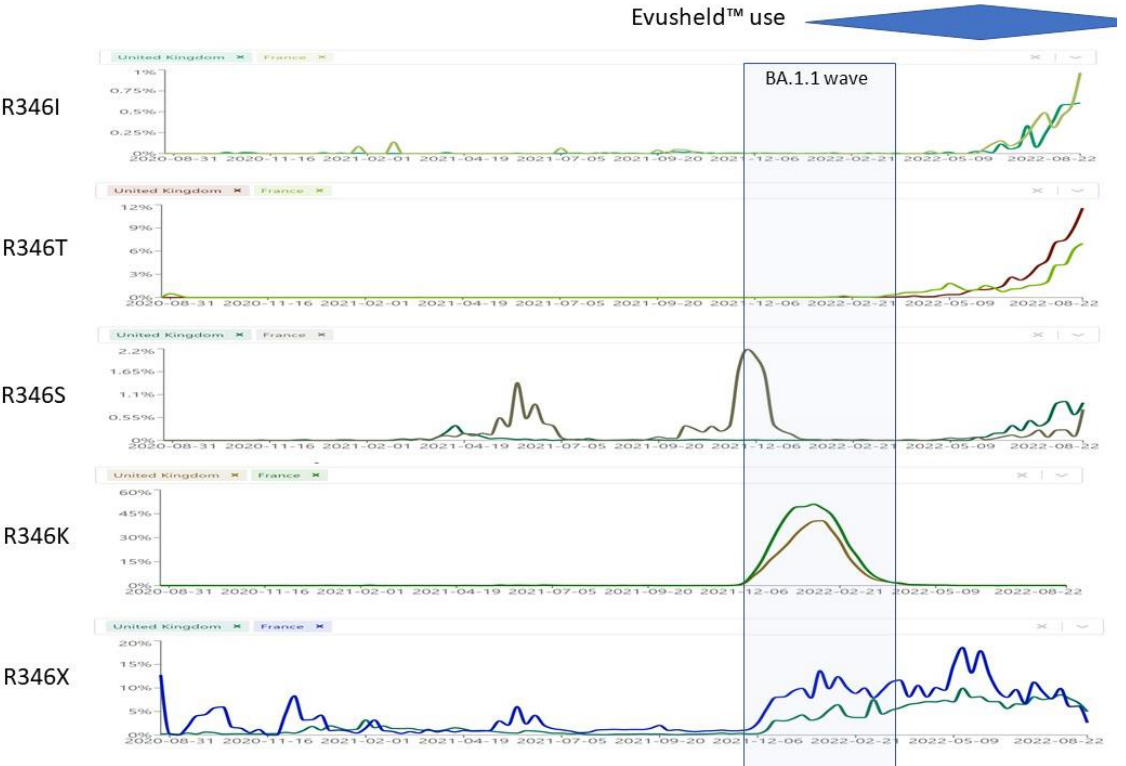
Figure 8. Prevalence of S:R346X mutations in the period 27 August 2022 – 13 September 2022 in UK versus France. Sourced from https://cov-spectrum.org (accessed on 26 November 2022). The blue area represents trends in Evusheld ™ prescriptions in France and many other countries (but not UK).